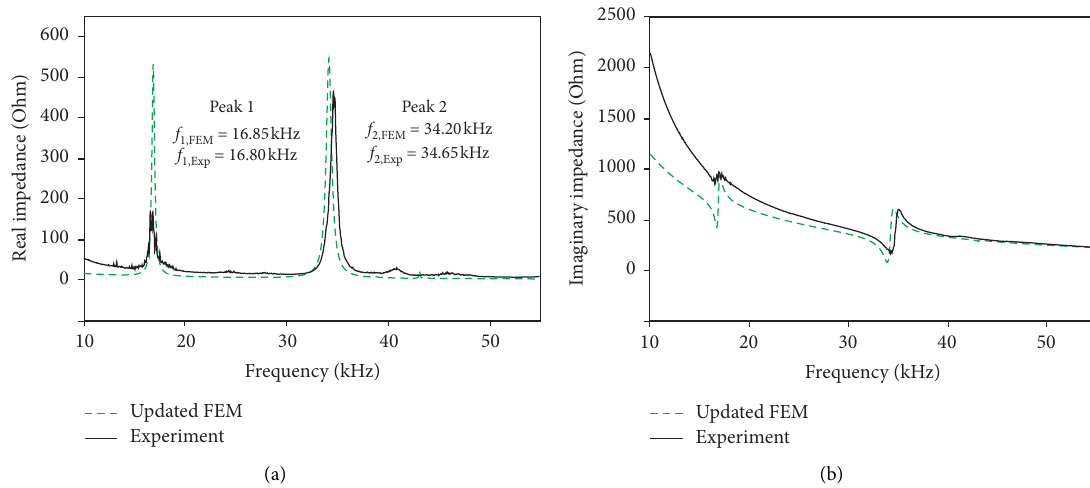
Figure 12: EMI responses after updating peak frequencies. (a) Real impedance. (b) Imaginary impedance.